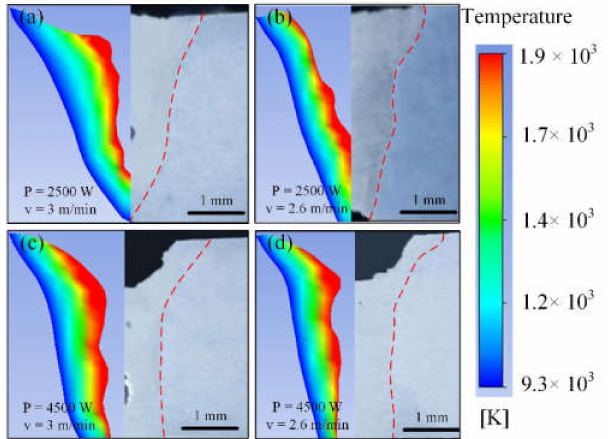
Figure 5. Verification results of thermal-flow coupling model in laser welding process of 6061 Aluminum Alloy plate butt structure: ( a ) P = 2500 W, v = 3 m/min; ( b ) P = 2500 W, v = 2.6 m/min; ( c ) P = 4500 W, v = 3 m/min; ( d ) P = 4500 W, v = 2.6